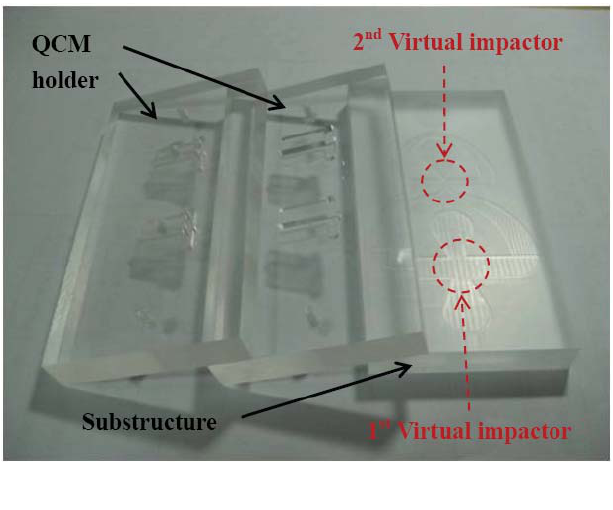
Figure 5. Photograph of the fabricated